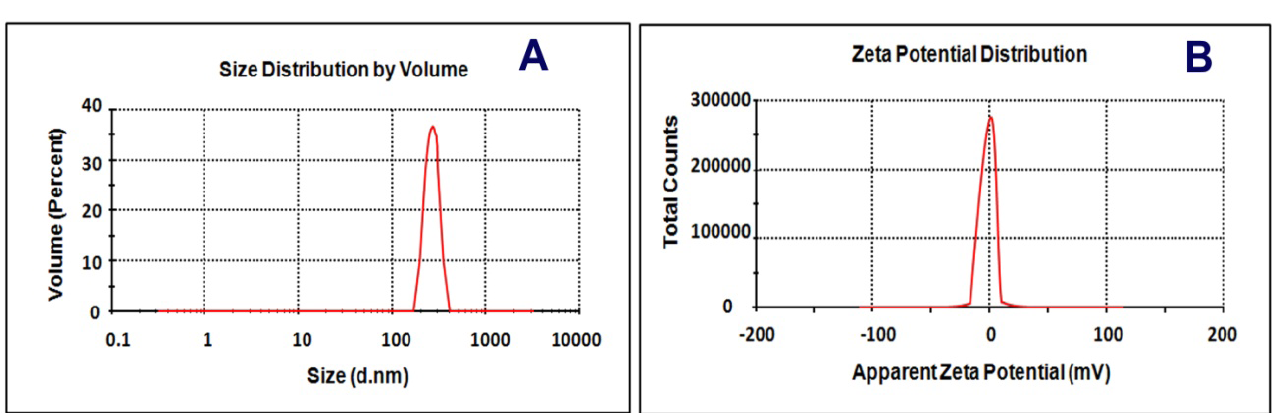
FIGURE 1 – Particle size (A) and zeta potential (B) optimized formulation, MTX-MS2.